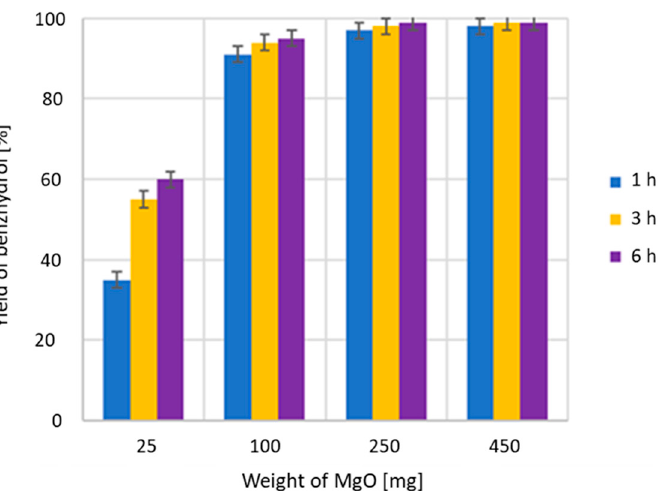
Figure 4. Influence of the weight of MgO on the reaction yield in liquid phase transfer hydrogenation of benzophenone with 2-octanol in the presence of MgO catalyst. Reaction conditions: W MgO = var, 3.125 mmol of ketone, D/A = 8, selectivity >98%.